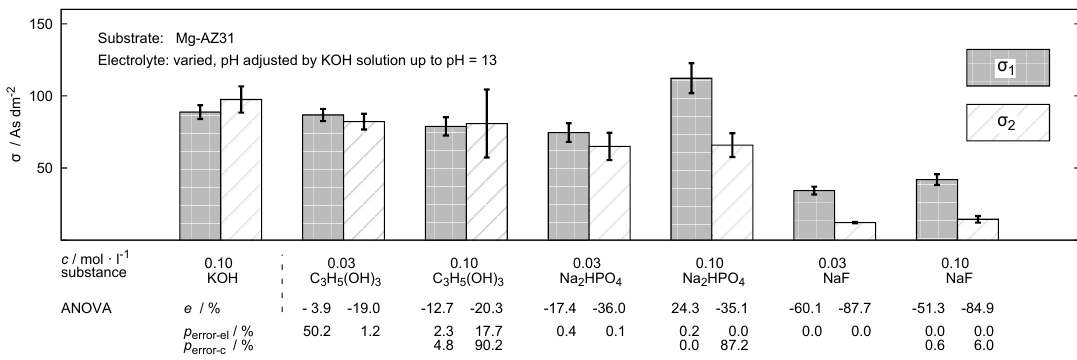
Figure 9. Comparison of the σ -values of the measurements shown in Figures 6a and 8, as well as the percentage effect size e of the different electrolyte variations and the error probability p error assuming the effect of an certain electrolyte component and the elevation of its concentration as statistically